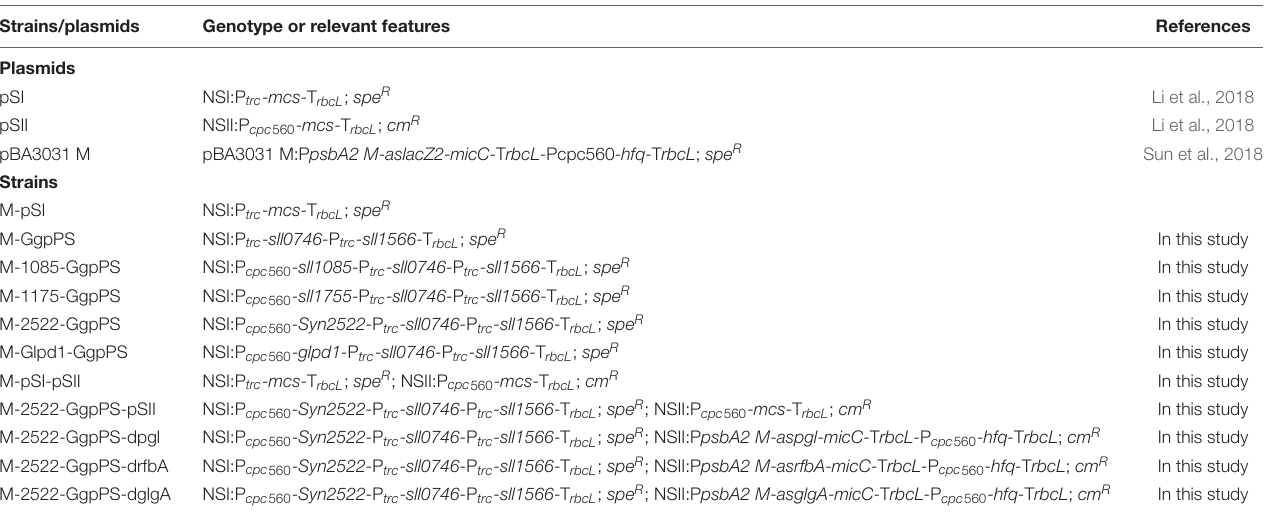
TABLE 1 | Strains and plasmids used in this